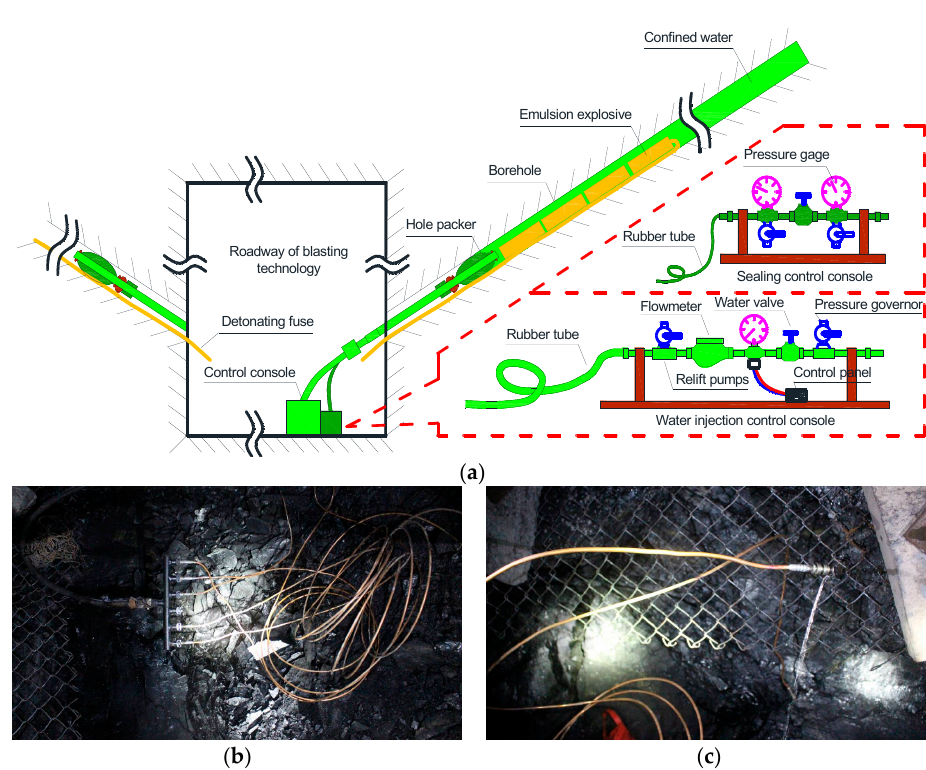
Figure 13. Schematic of water injection for the blast holes: ( a ) Profile of a water-filled blast hole; ( b ) Synchronous water injection into multiple holes; ( c ) Discharge from the outlet pipes.